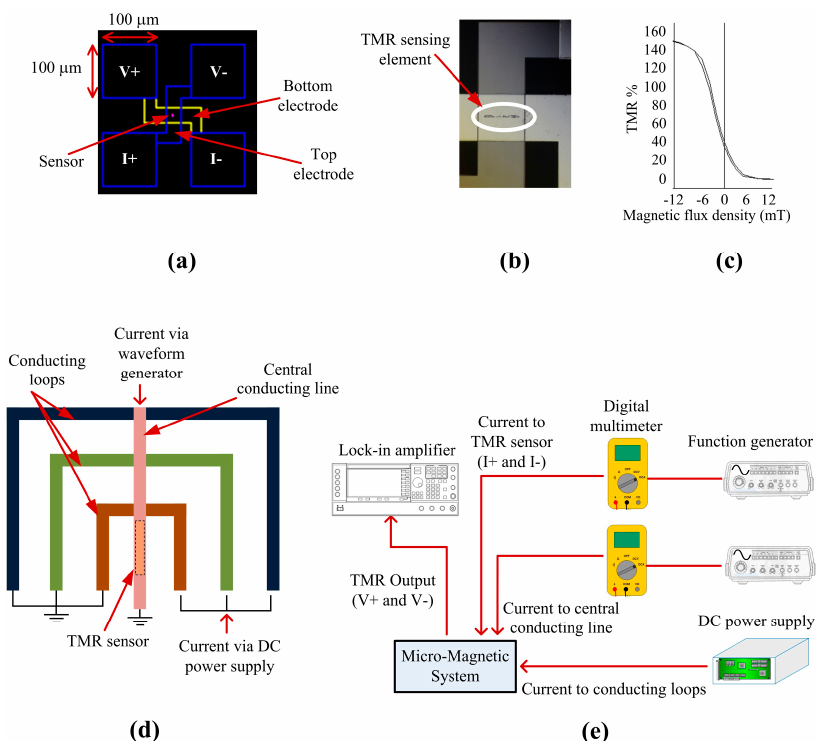
Figure 3. ( a ) Design of the TMR sensor; ( b ) Fabricated TMR sensing element; ( c ) Sensitivity of the TMR sensor; ( d ) MA and TMR sensor integration; ( e ) Experimental setup for magnetic bead detection.